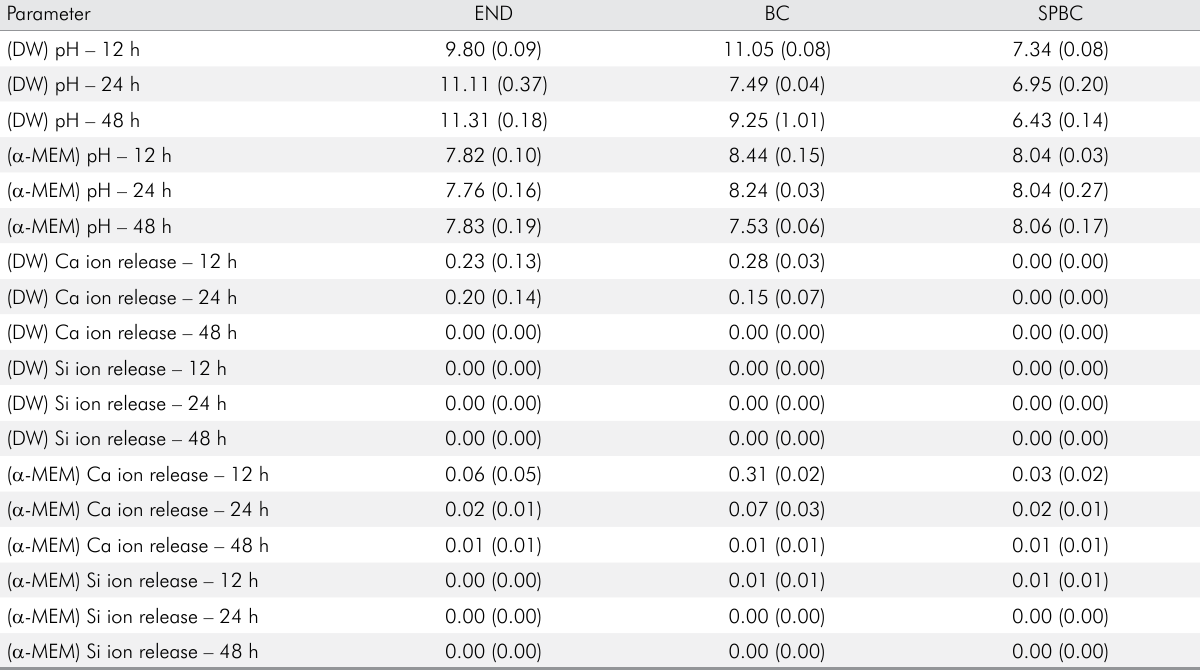
Table 3. Mean and standard deviation values for pH and calcium/silicon released (ppm) by the calcium silicate-based sealers in soaking solutions and at the different experimental time